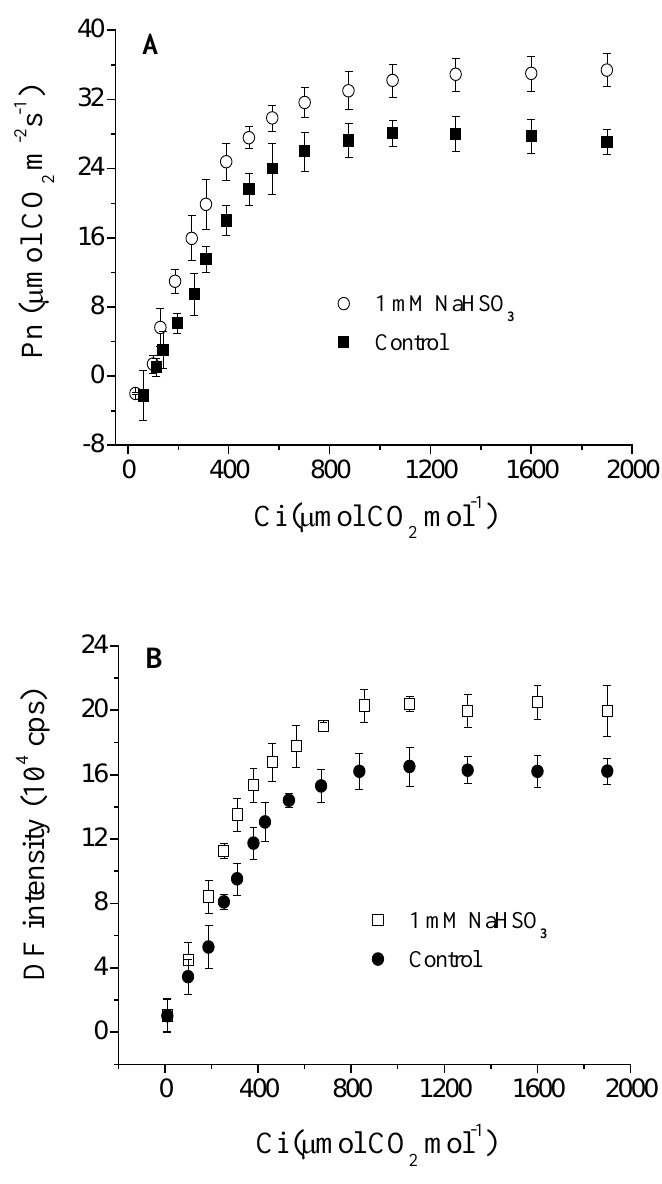
Figure 4. CO response curves of Pn (A) and DF intensity (B) of leaves of soybean ( Glycine max 2 Zaoshu No. 18) seedlings exposed to 1mM NaHSO concentration for 72 h. In the figure each value is 3 the mean ± S.E. of nine independent